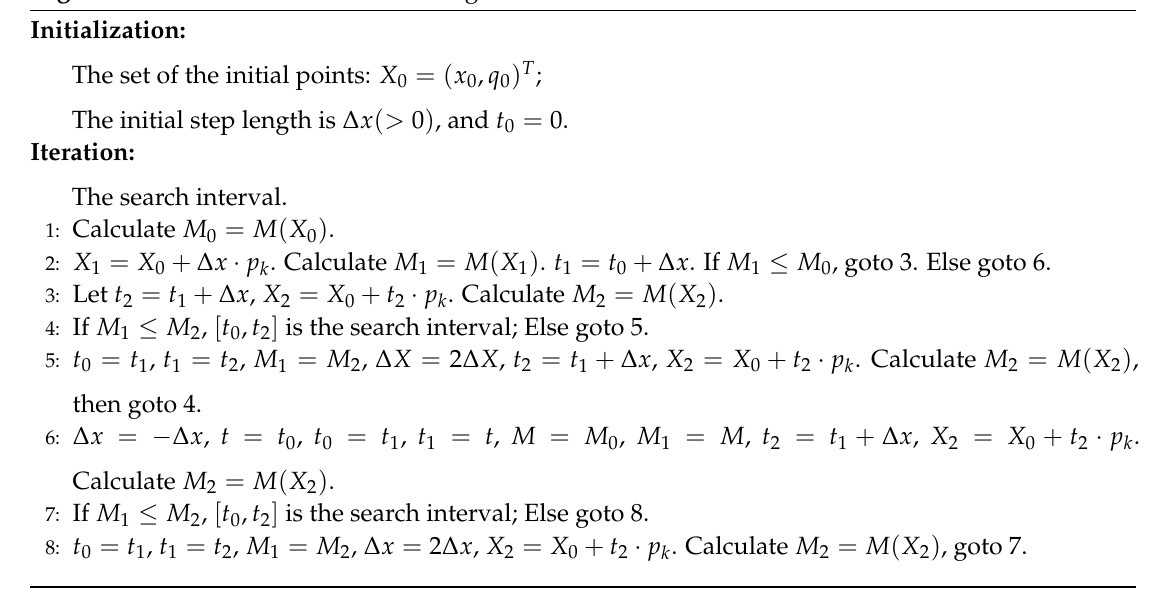
Algorithm 3 The advance and retreat algorithm.